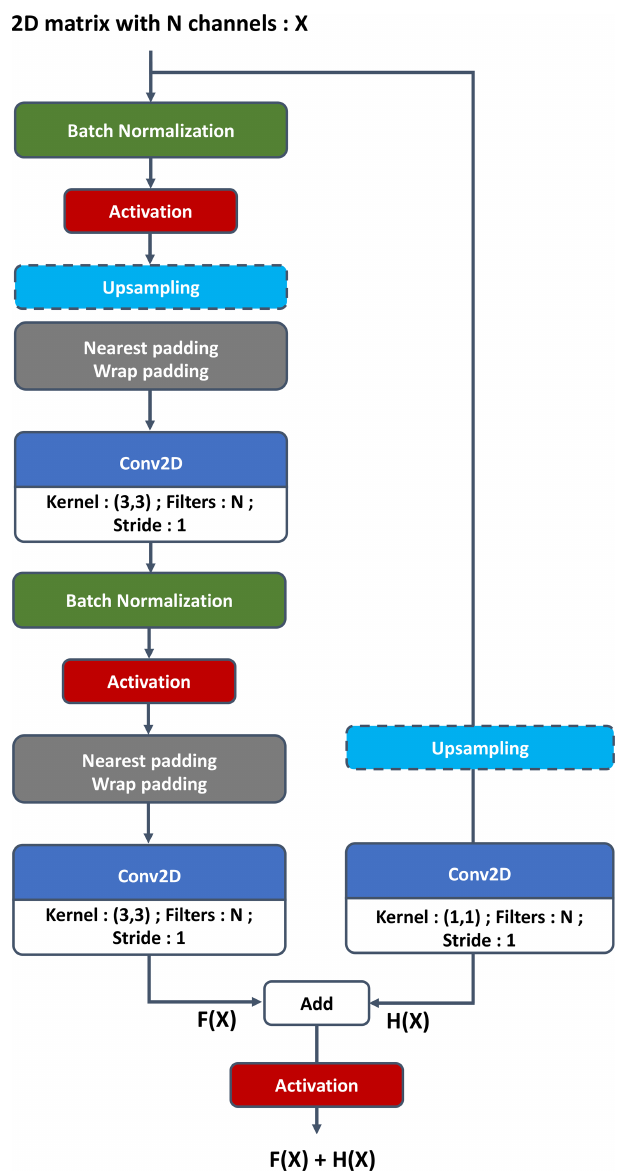
Figure 5. Residual convolutional block for the generator. The up- sampling layer can be removed if not necessary and is mentioned when used in Fig. 4.